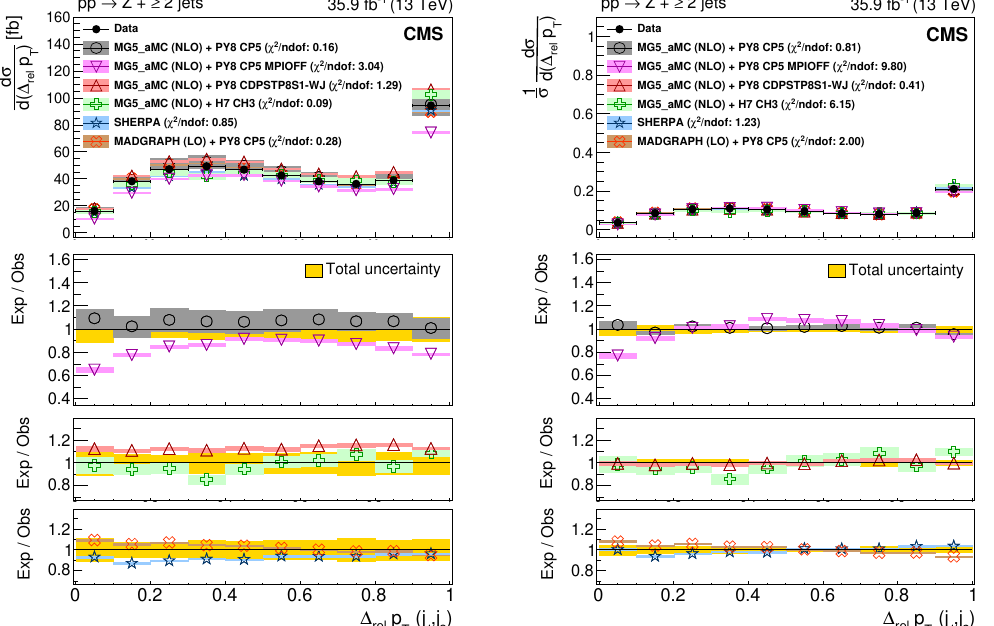
Figure 6 . Differential cross sections (left) and area-normalized distributions (right) as functions of the p imbalance between leading and subleading jets for Z + ≥ 2 jet events. The uncertainties in T the predictions are shown as coloured bands around the theoretical predictions including statistical, PDF, scale, and tune uncertainties for the NLO MG5_aMC + pythia 8 (with CP5 tune) and the statistical uncertainty only for the LO MG5_aMC + pythia 8 (with CP5 tune), NLO MG5_aMC + pythia 8 (with CDPSTP8S1-WJ tune, CP5 tune with MPI-OFF), NLO MG5_aMC + herwig 7 (with tune CH3), and sherpa predictions. In the top panel, the vertical bars on the data points represent statistical uncertainties, whereas in the bottom panels, the total uncertainty in data is indicated by the solid yellow band centred at 1. In the legend, the χ 2 per degree of freedom is given to quantify the goodness of fit of the model to the